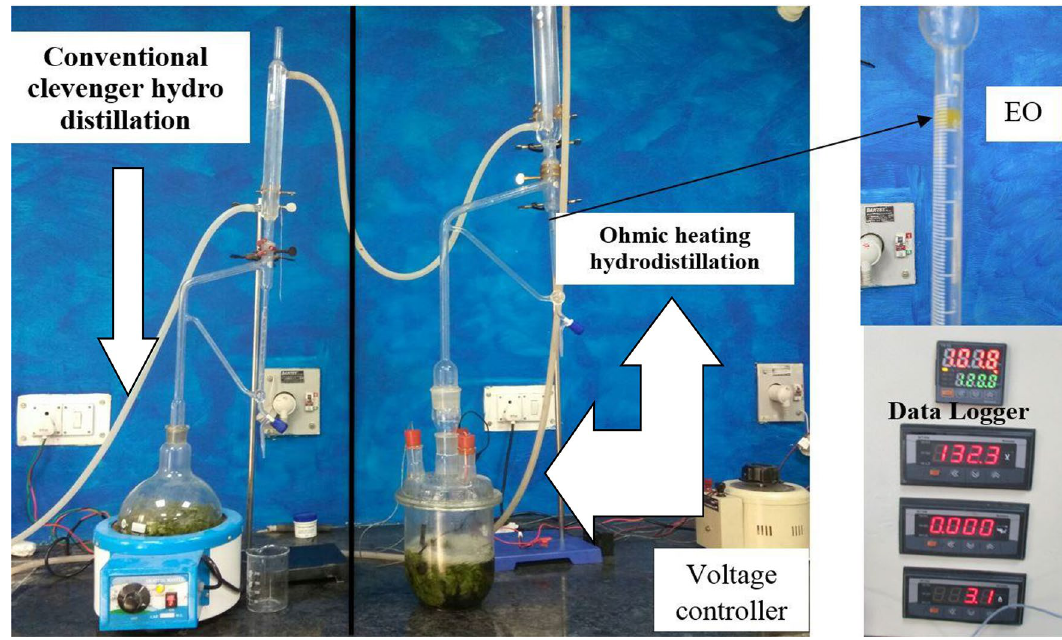
Figure 4. Conventional clevenger and ohmic heating hydro-distillation systems.